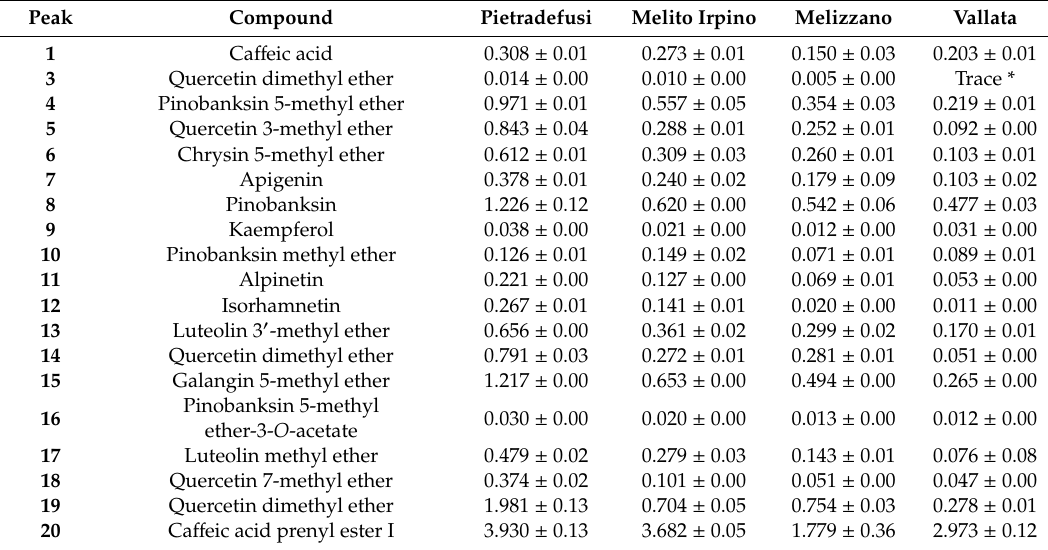
Table 3. Quantitative amount (g / 100 g ± standard deviation of raw propolis) of constituents detected in the propolis